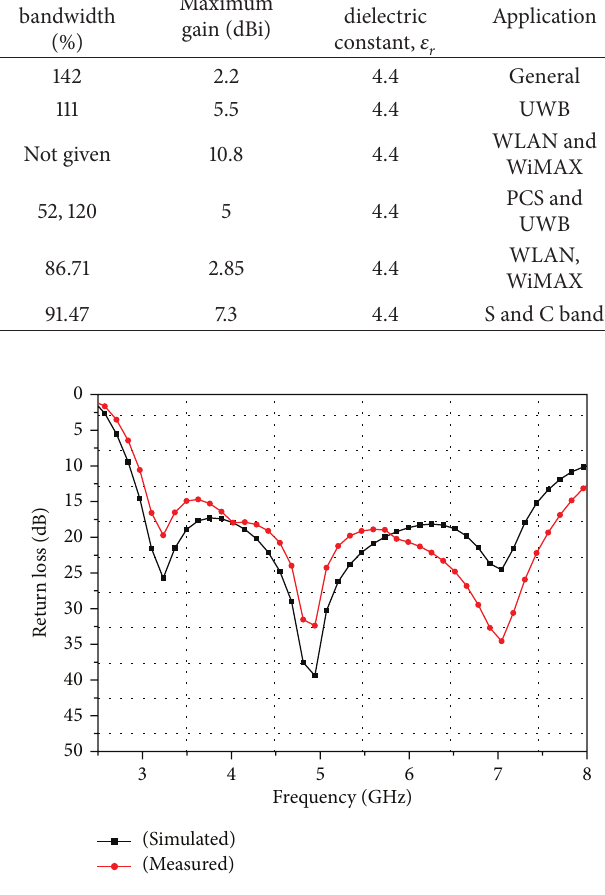
Figure 8: Measured and simulated return loss for the proposed CPW-fed two-sided T strip wideband microstrip